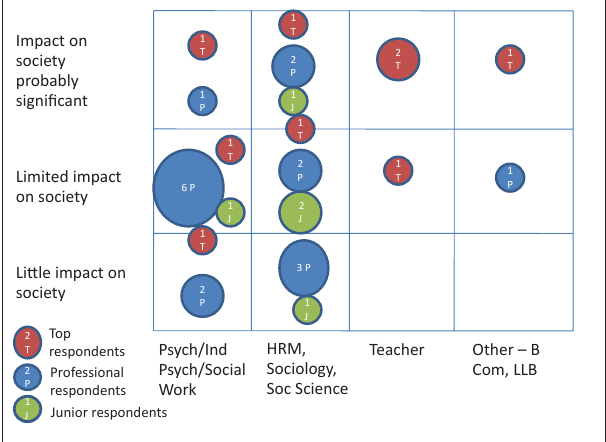
FIGURE 3: Views on HR’s contribution